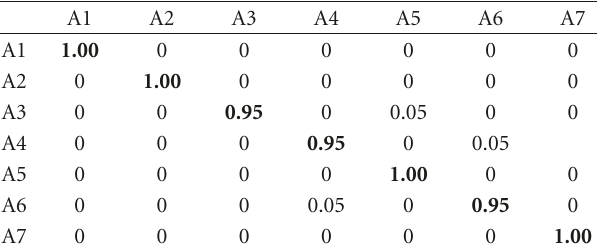
Table 1: The recognition rate of 7 motions at 5 resolution levels.